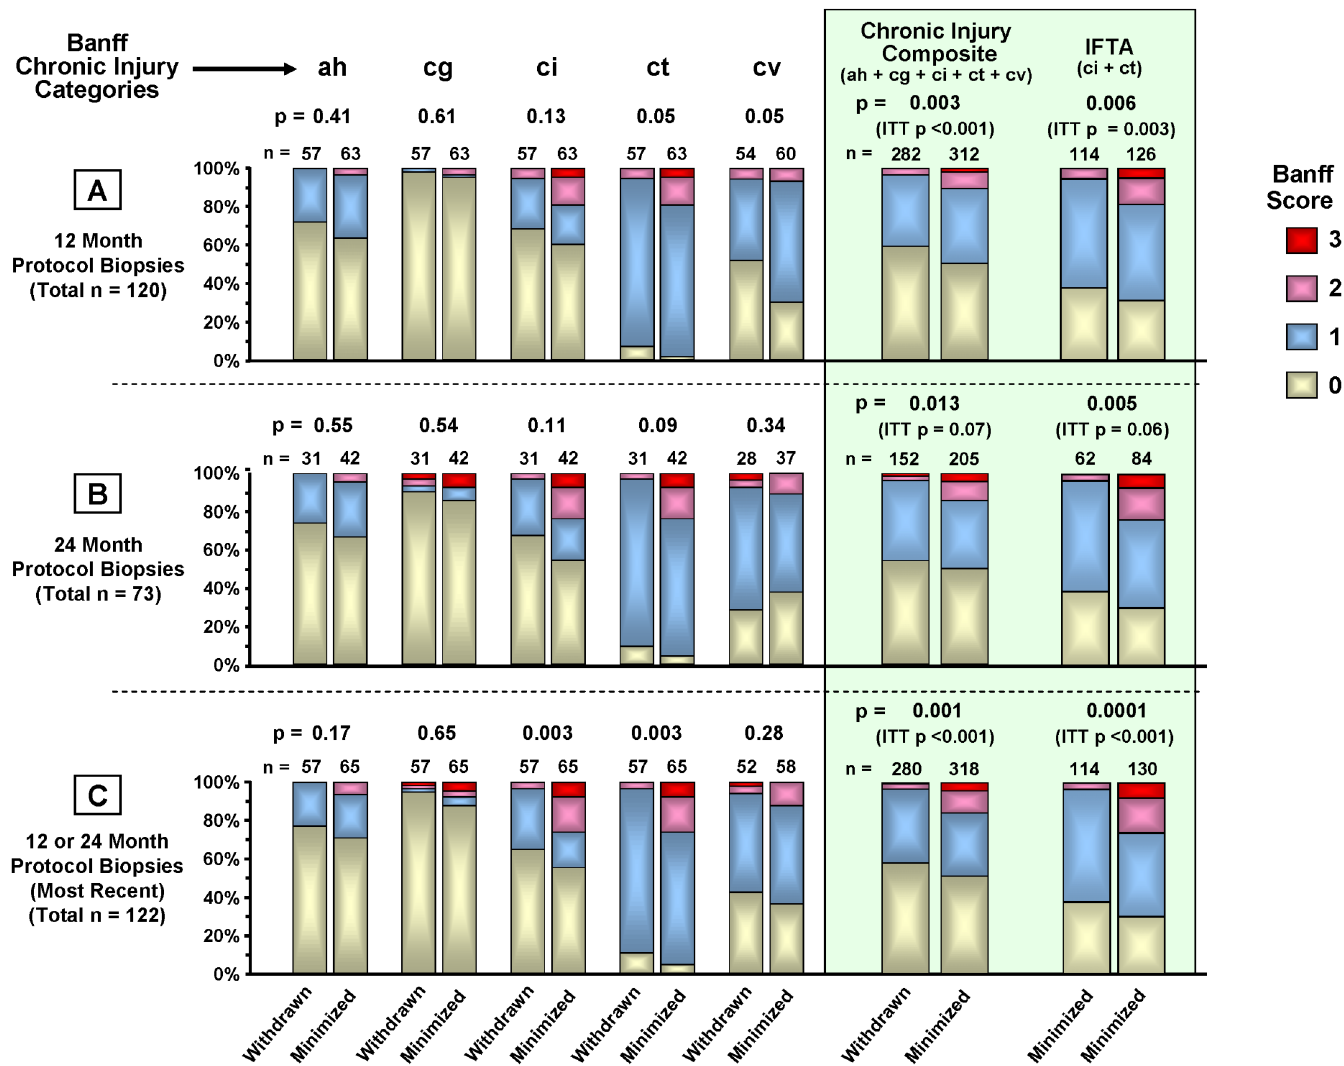
Fig 4. Chronic Banff injury score distributions by on-treatment CNI withdrawal status. Protocol biopsies collected at approximately 12 and 24 months were scored by a transplant renal pathologist blinded to treatment group assignment (author K.F.) for evidence of rejection, BK virus nephropathy, antibody- mediated rejection, recurrent disease, inflammation, and Banff 2005 categories of chronic renal injury. Chronic injury categories were arteriolar hyaline thickening (ah), allograft glomerulopathy (cg), interstitial fibrosis (ci), tubular atrophy (ct), and vascular fibrous intimal thickening (cv). A chronic injury composite score for each group was also created from the five individual injury category scores. Severity scores within each category could be 0 ( < 5%; none or minimal), 1 ( > 5% — < 25%; mild), 2 ( > 25% — < 50%, moderate), or 3 ( > 50%, severe). The composite scores shown are the total numbers of ah, cg, ci, ct, and cv scores in each severity grade (0, 1, 2, or 3). The proportions of patients in each severity grade (0, 1, 2, and 3) for both the individual categories and the composite were compared using Fisher ’ s exact test. Intent-to-treat (ITT) p-values are included in the